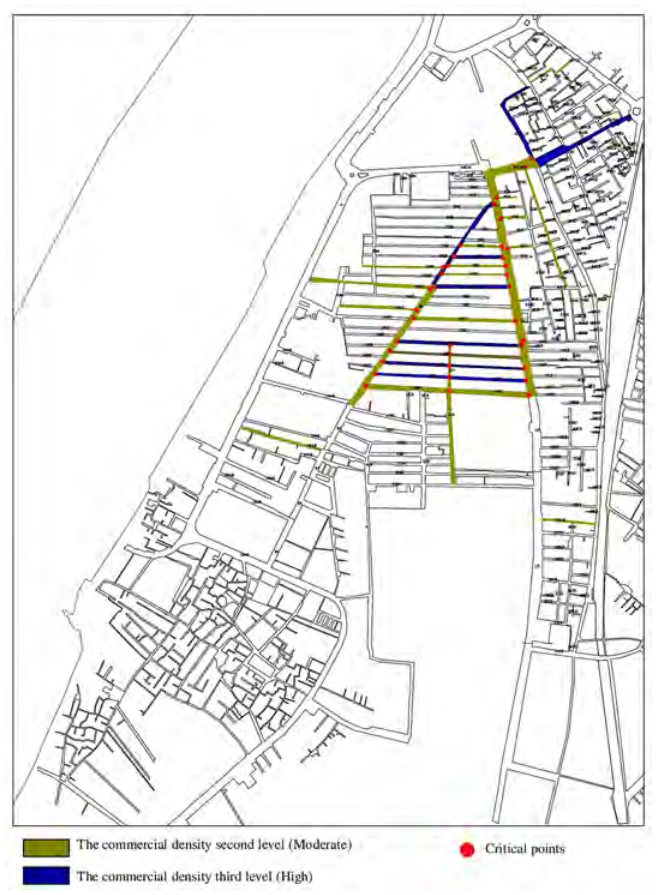
Figure 4. The crowded streets and critical points